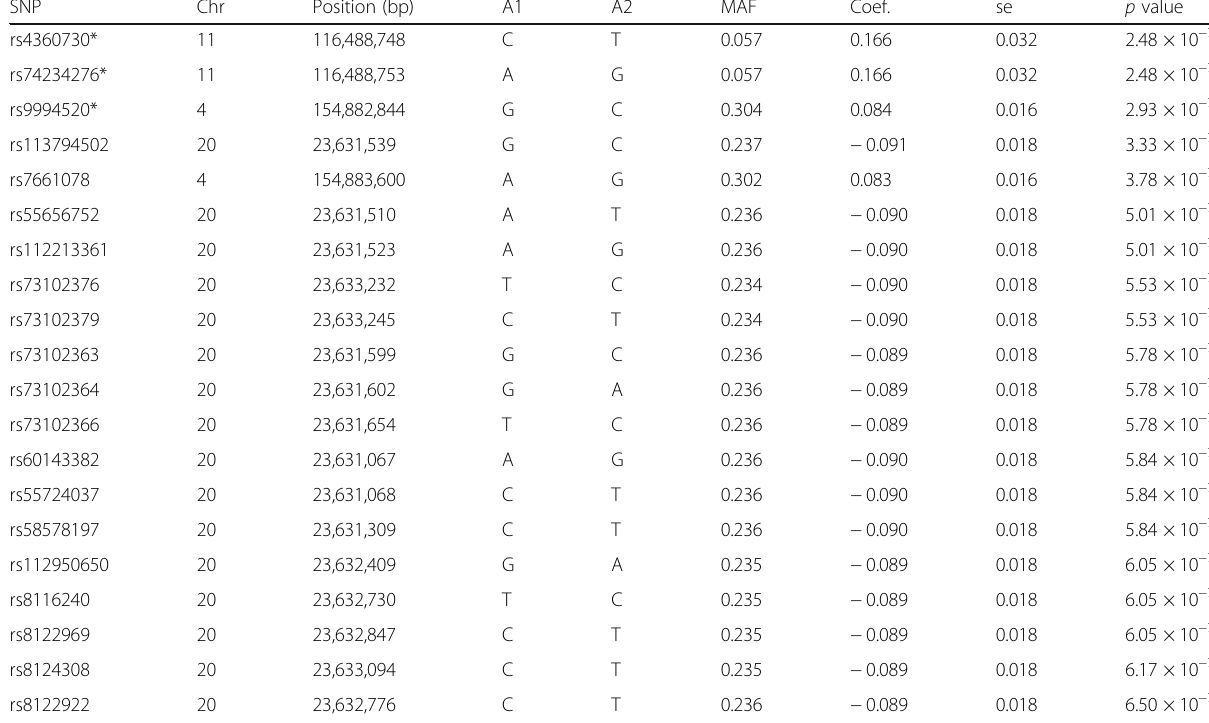
Table 5 SNPs associated with change in circulating ANGPTL3 during weight loss intervention ( p < 1 × 10 − 5 ) SNP Chr Position